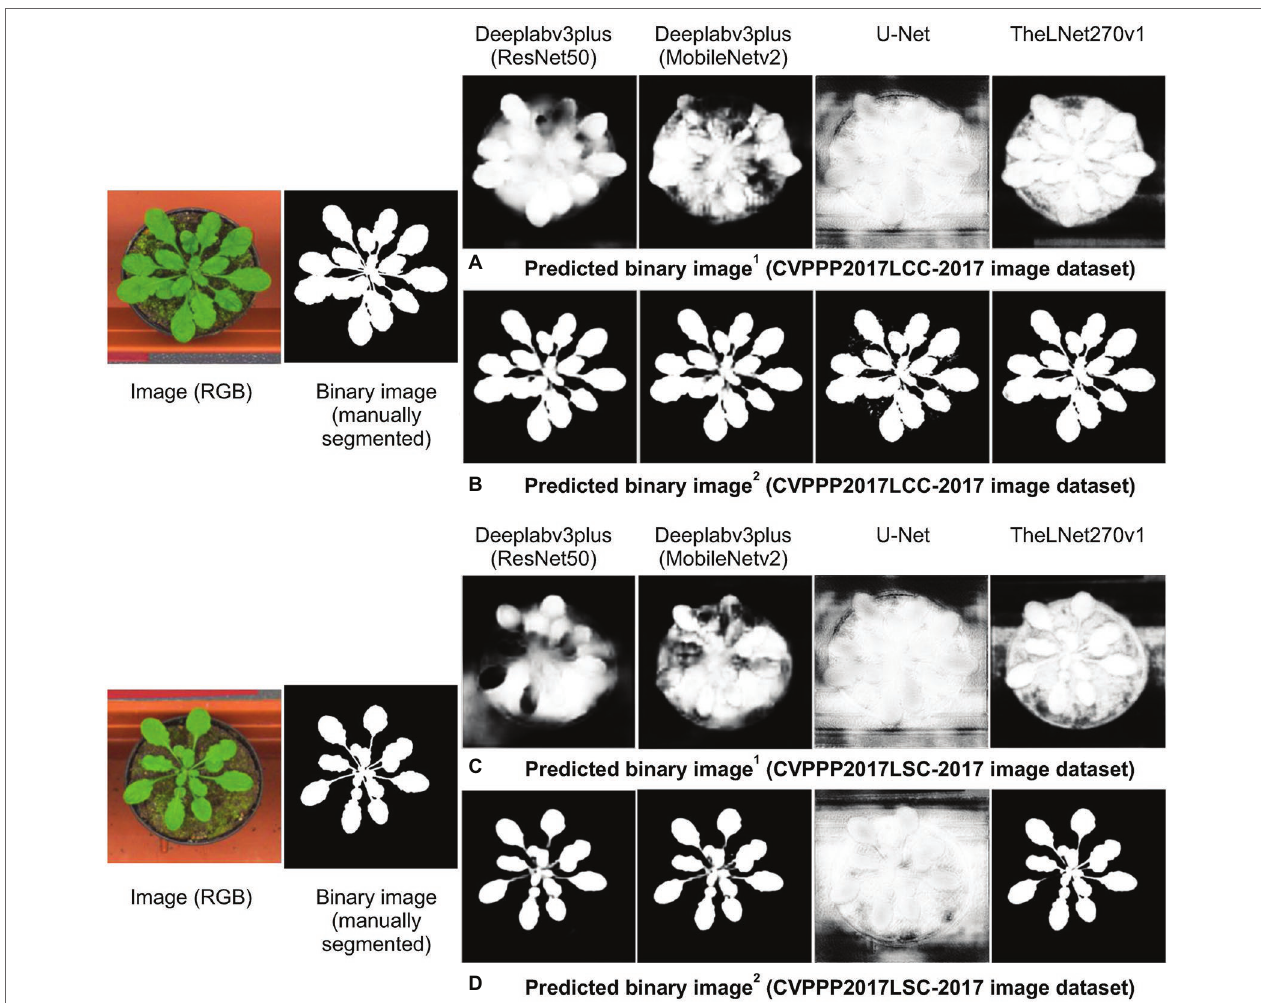
FIGURE 15 | Verification of the prediction capability. (A) Comparison of manually segmented data with the predicted image from augmented 1 CVPPP2017LCC-2017 data. (B) Comparison of manually segmented data with the predicted image from augmented 2 CVPPP2017LCC-2017 data. (C) Comparison of manually segmented data with the predicted image from augmented 1 CVPPP2017LSC-2017 data. (D) Comparison of manually segmented data with the predicted image from augmented 2 CVPPP2017LSC-2017